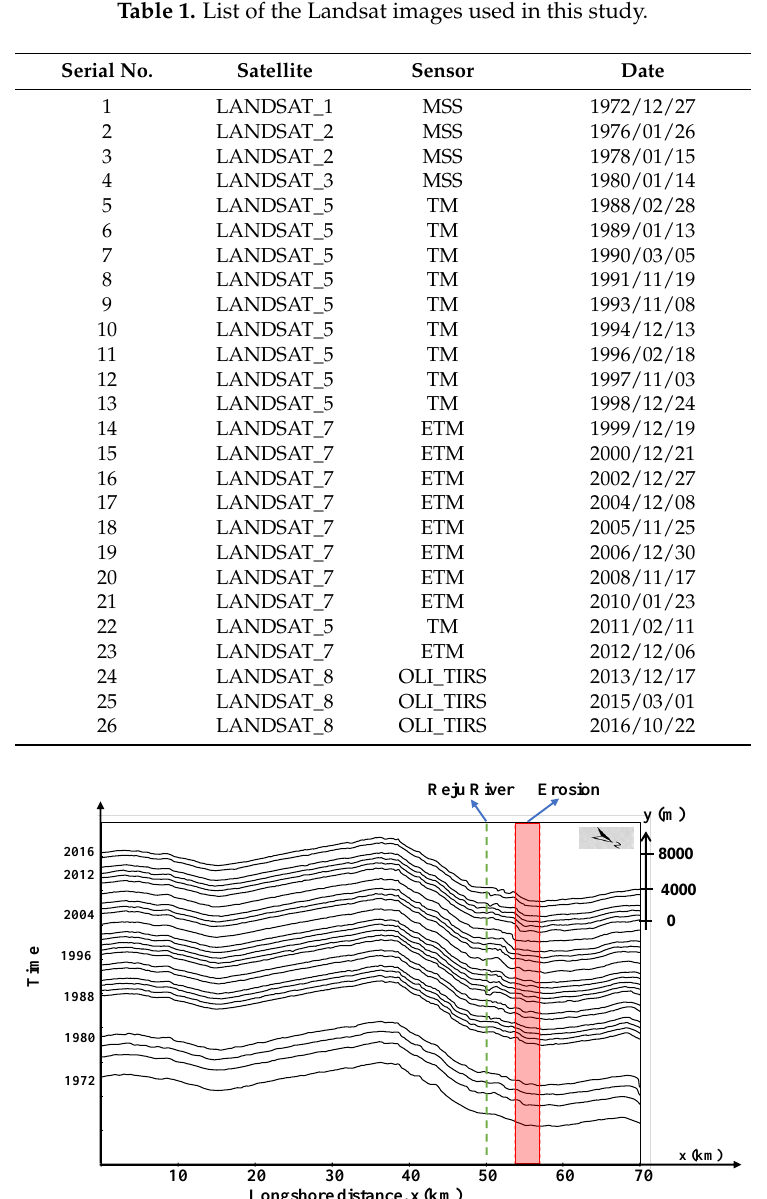
Table 1. List of the Landsat images used in this study. Serial No.